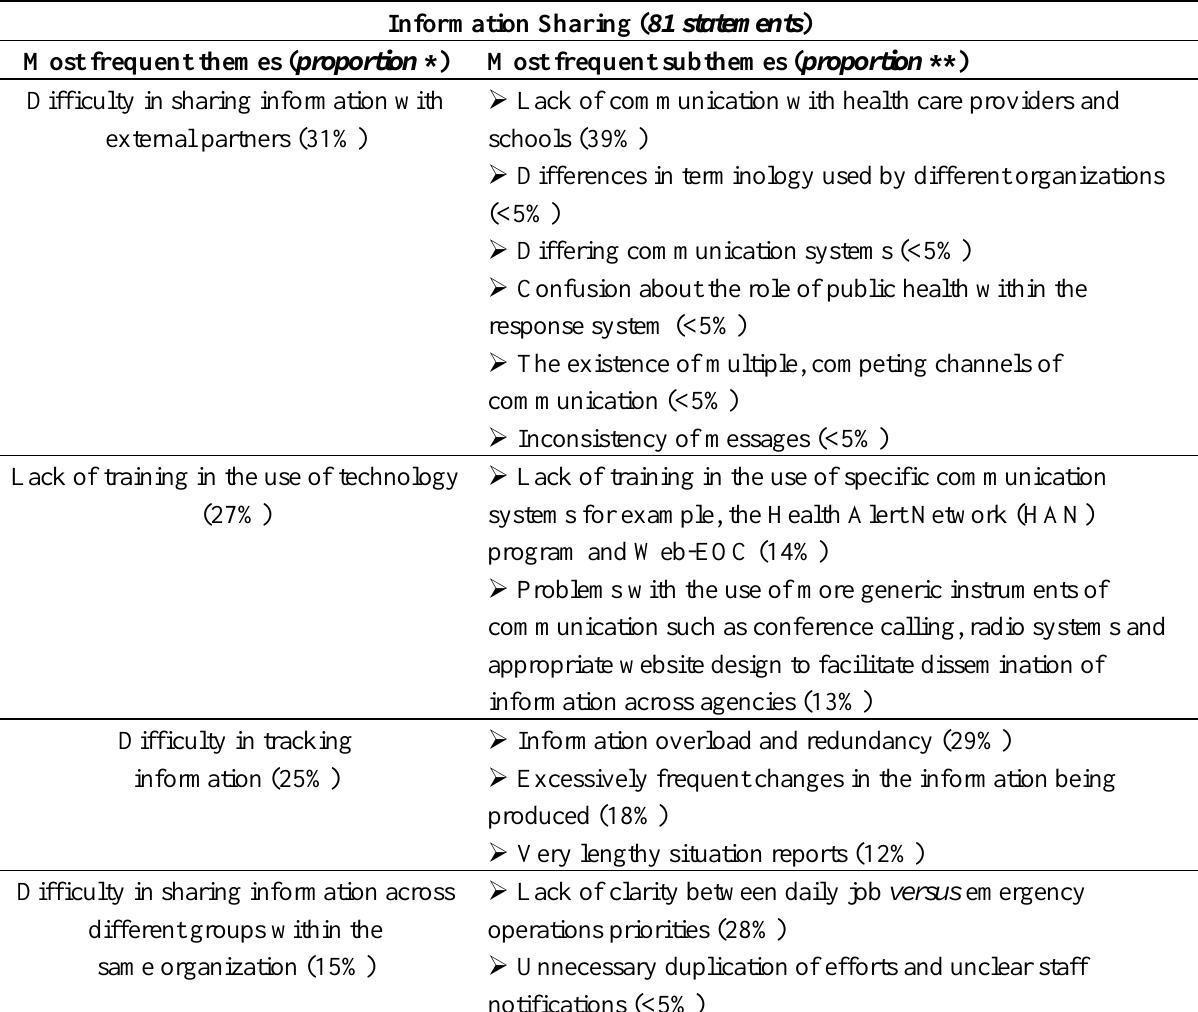
Table 2. Analysis of themes and sub-themes for the capability of information